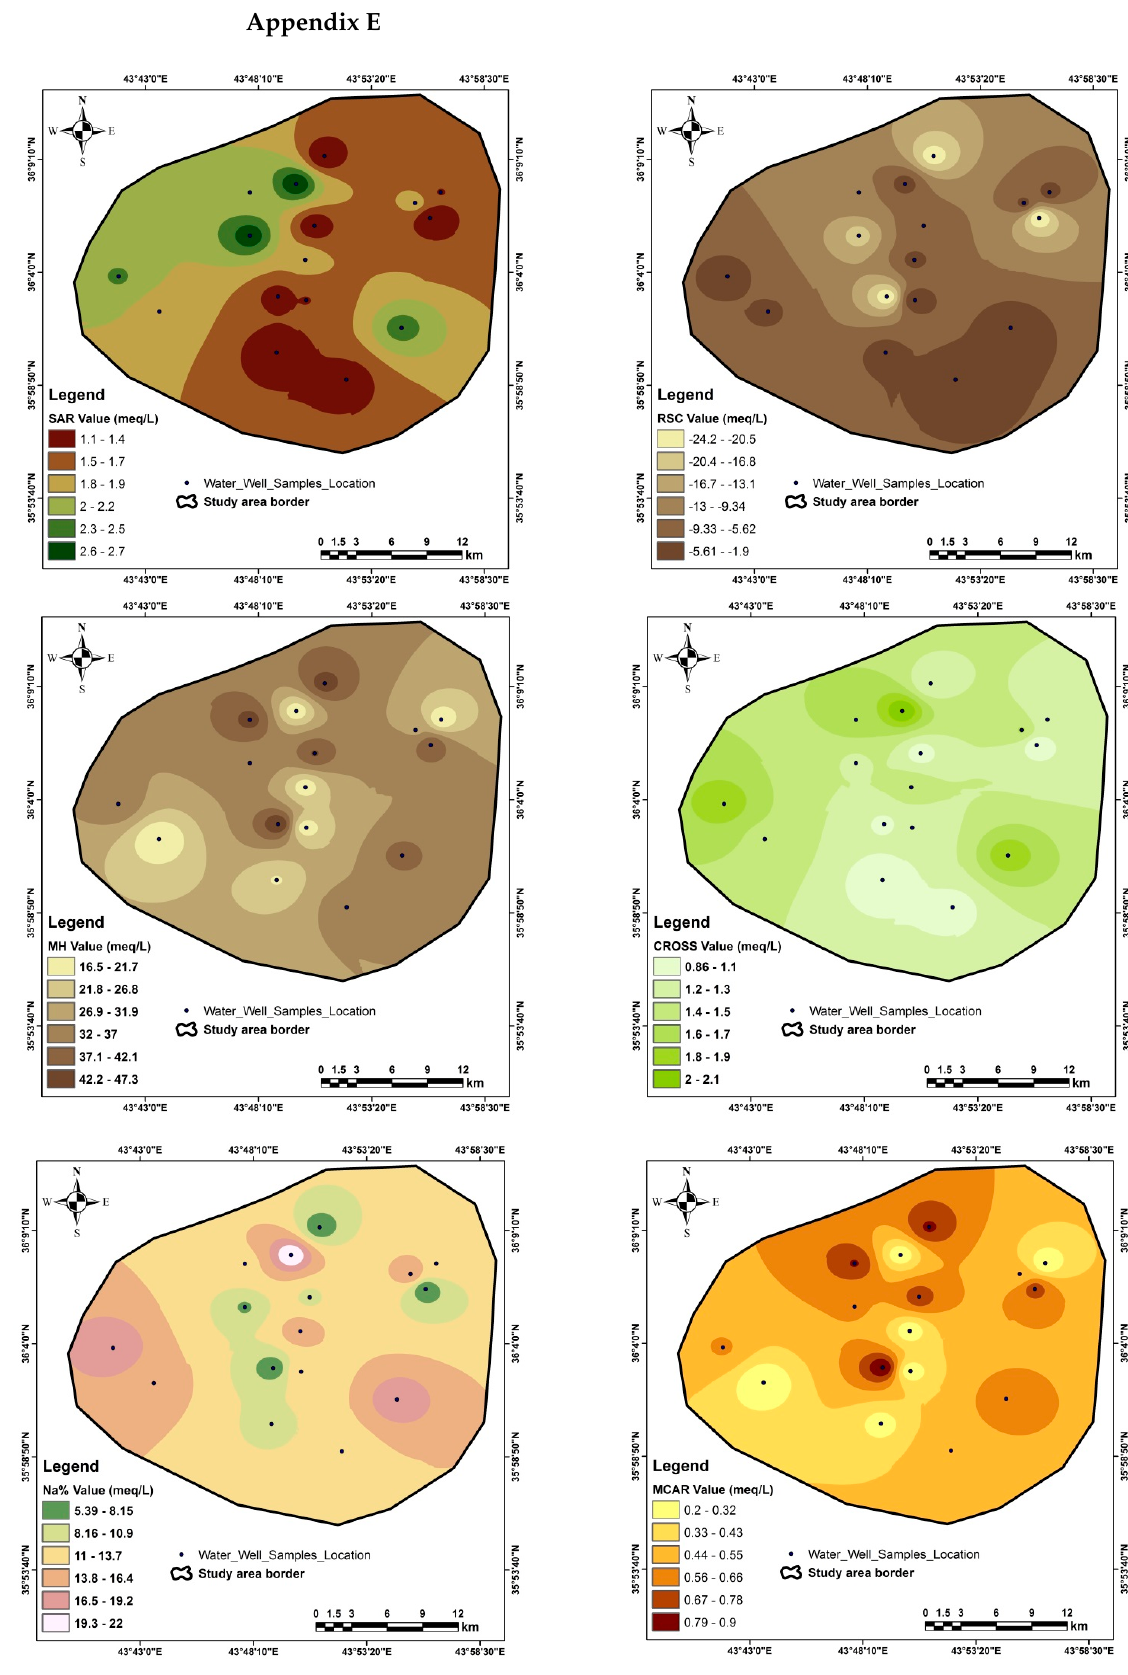
Figure A4. Special distribution of the quality assessment parameters in the study area.